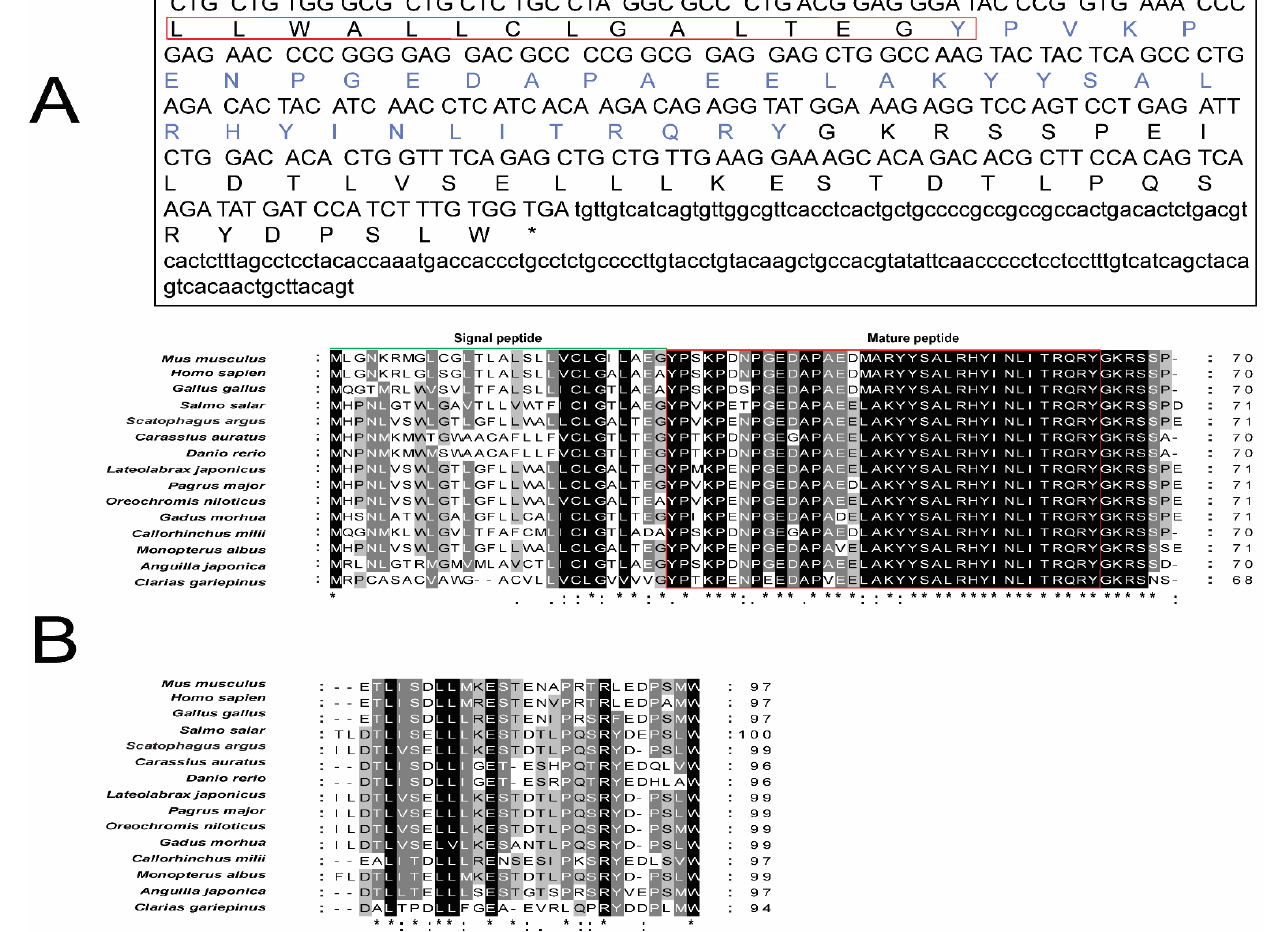
Figure 1. ( A ) Nucleotide and deduced amino acid sequence of spotted scat Npy . The supposed signal peptide of Npy is boxed, and the matured peptide is written in blue. The stop codon is indicated by an asterisk (*). ( B ) Comparison of the amino acid sequence of Scatophagus argus Npy against that of Mus musculus (NP_075945.1), Homo sapien (NP_000896.1), Gallus gallus (NP_990804.1), Salmo salar (NP_001140153.1), Carassius auratus (XP_026087265.1), Danio rerio (NP_571149.1), Lateolabrax japonicus (AIK01745.1), Pagrus major (BBA20652.1), Oreochromis niloticus (XP_003448902.1), Gadus morhua (XP_030203389.1), Callorhinchus milii (ACF22970.1), Monopterus albus (AEX97166.1), Anguilla japonica (AFN84517.1), and Clarias gariepinus (AOZ35531.1). (*) indicates positions that have a fully conserved residue, (:) indicates conservation between groups of strongly similar properties, and (.) indicates conservation between groups of weakly similar properties. Green line indicates the signal peptide of each organism whiles the boxed area in red indicates the matured peptide of the spotted scat Npy and the Npy of other organisms.